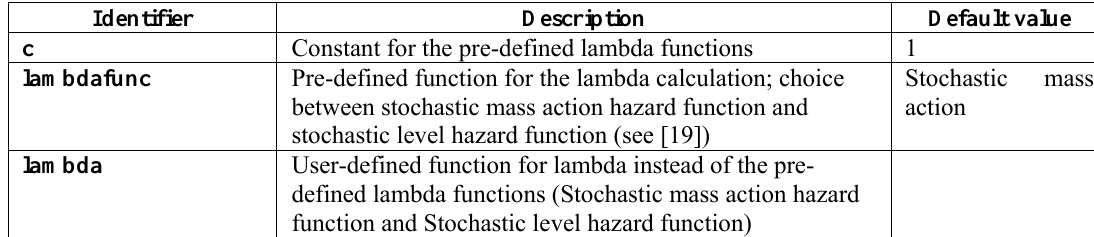
Table 5: Parameters only of a stochastic